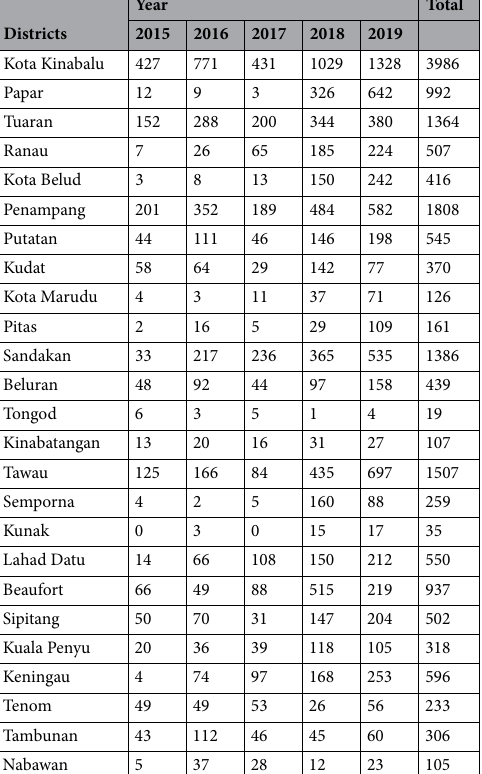
year. Males accounted for most of the cases (male-to-female ratio of 1.3:1), and one-year-old children had the highest number of cases for both genders. Spatial trends across districts. Among the 25 districts, Kota Kinabalu reported the highest number of HFMD cases every year (total 3986 cases), with a peak of 1328 cases in 2019 (Table 2). On the contrary, Tongod district had the lowest number of cases, with just 19 cases reported throughout the five years. Of the 25 districts, a peak in the number of cases was observed in 17 (68%) districts in 2019, five (20%) districts in 2018, two (8%) districts in 2016, and one (4%) district in 2015. The annual spatial trend dynamics are shown in Fig. 2, indicat- ing that there was a yearly variation across districts. Throughout the five-year study period, the district with the largest variation in annual incidence rate was Beaufort (58 per 100,000 people in 2016 to 657 per 100,000 people in 2018) while Kinabatangan had the smallest variation in annual incidence rate, ranging from 8 per 100,000 people in 2015 to 18 per 100,000 in 2018. A prominent spatial change was observed in 2018, when incidence increased markedly in the western regions of Sabah from the previous year. High incidence rates were not only found in densely populated districts, such as Kota Kinabalu, Putatan and Penampang, but also in low population density districts, including Sipitang, Beaufort, Kuala Penyu and Kota Belud. The highest incidence district was Kuala Penyu with a five-year average annual incidence of 257 per 100,000 people, while the lowest were Tongod and Kunak districts, both with 9 per 100,000 people. Phylogenetic analysis of enteroviruses. A total of 21 swab samples were collected from 13 children during an outbreak reported in Beaufort, Sabah, in August 2018. Swabs from six children comprising of four females and two males, ranging from one to seven years old were tested positive for enteroviruses using snRT- PCR. Sequence analysis of the VP1 gene of the positive snRT-PCR samples by BLAST identified five (83.3%) CVA16 and one (16.7%) EV71 serotypes. The partial VP1 sequences of the CVA16 and EV71 viruses were 254 bp and 359 bp in length, respectively. These partial VP1 sequences were used to construct the phylogenetic trees of the two serotypes. This is the first study that shows the genetic characteristics of CVA16 strains from Sabah. According to the phylogenetic analysis, all five CVA16 strains detected in this study were classified as genotype B, specifically sub- genotype B1a. Three CVA16 strains clustered with Thai strains from 2017, while the other three clustered with